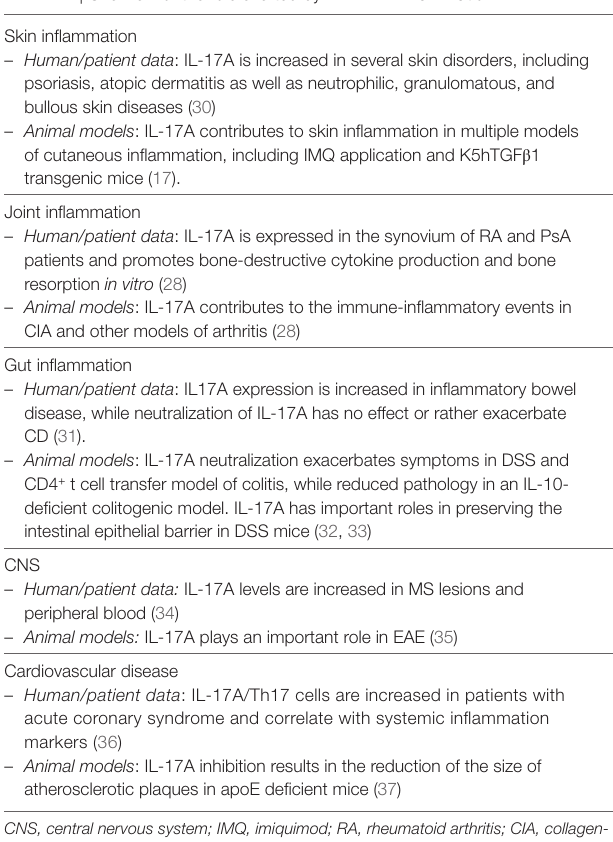
sclerosis; EAE, experimental autoimmune